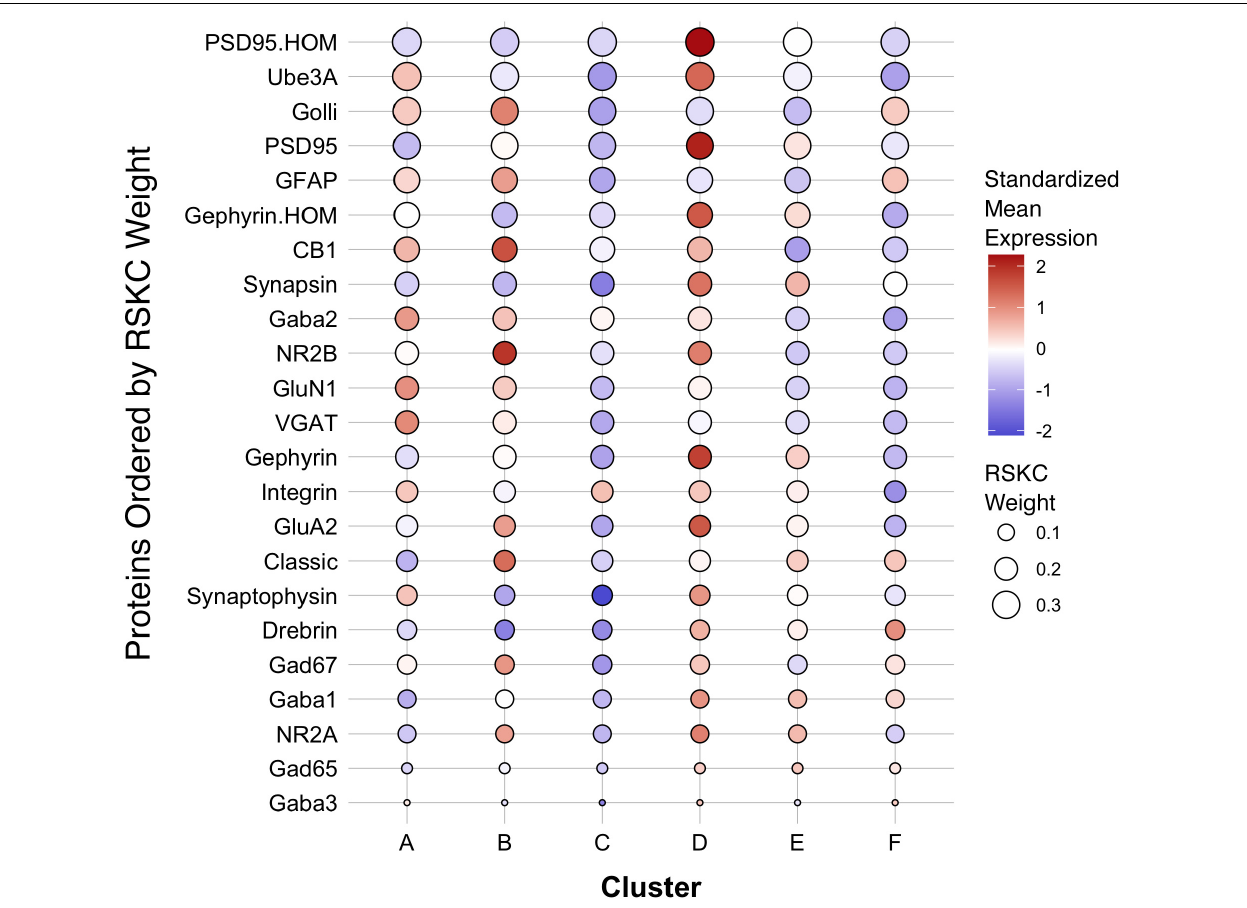
FIGURE 9 | Bubble plot of mean protein expression across each cluster. Proteins are ordered by their corresponding RSKC weight with the highest weighted protein arranged at the top, and the lowest weighted protein at the bottom and ordered by developmental cluster from left to right. The color of the dot represents standardized protein expression for each cluster, while the size of the dot represents the RSKC weight (see legend).